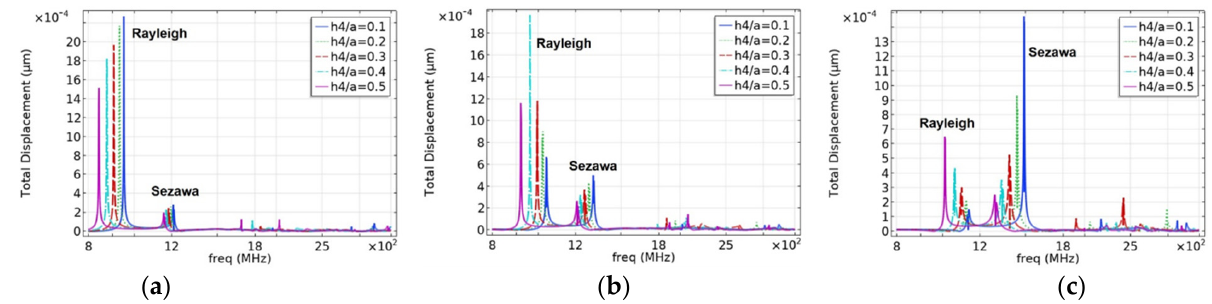
Figure 6. The effect of electrode thickness on resonant displacement. ( a ) When h 1 / a = 1.0. ( b ) When h 1 / a = 0.8 and ( c ) when h 1 / a = 0.6.